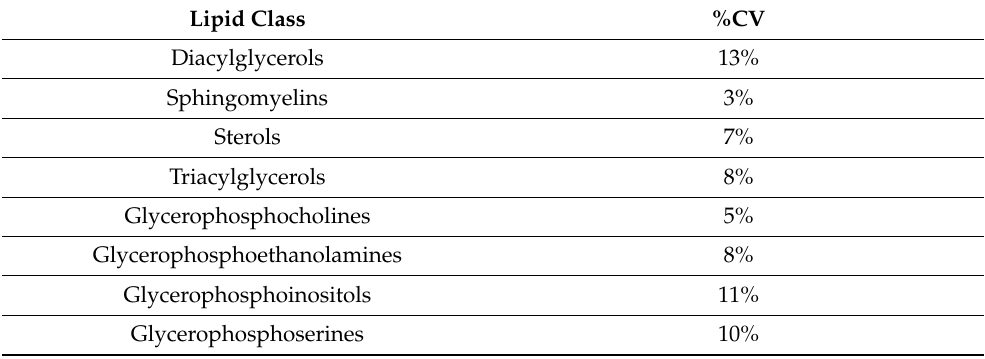
Table 1. Quality Control Precision showing percent coefficients of variation among various lipids measured using human plasma quality control samples to validate instrument